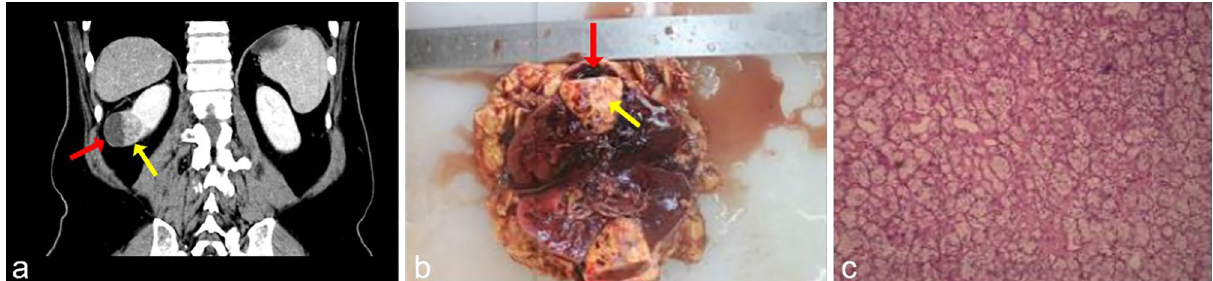
Figure 2. A 60-year-old male with a unilocular cRCC. ( a ) Postcontrast CT: unenhanced cyst fluid (red arrow) and solid component (yellow arrow). ( b , c ) Pathology report: Non-necrotic cyst and Fuhrman grade II clear cell carcinoma of the solid